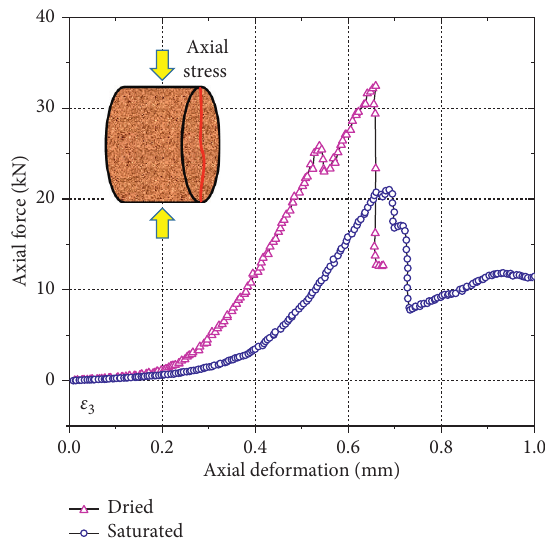
6: Axial force-axial deformation curve in Brazilian disk